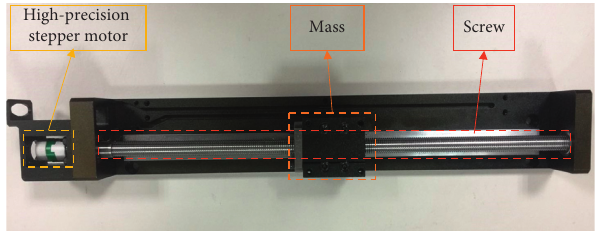
Figure 3: Dynamic disturbance torque compensation